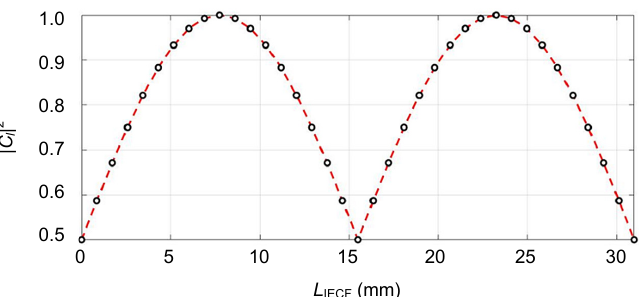
L IECF Fig. 7 | Purity of the first-order OAM mode generated by MSC 1 cascaded with IECF 1 at different values of L IECF .